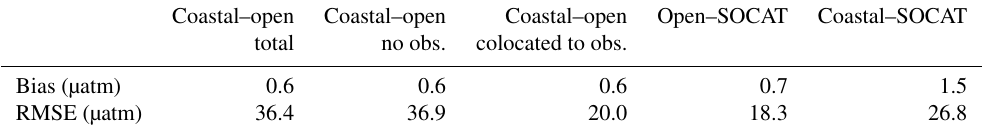
Table 1. Mean error analysis (bias and RMSE) within the overlap area between NN coast and NN open and the observations from the SOCATv5 dataset. The comparison is performed for the total overlap area, the area fraction where no observations exist and the area covered by observations. The bias and RMSE between the p CO 2 map products and the SOCATv5 open and coastal datasets are also reported.